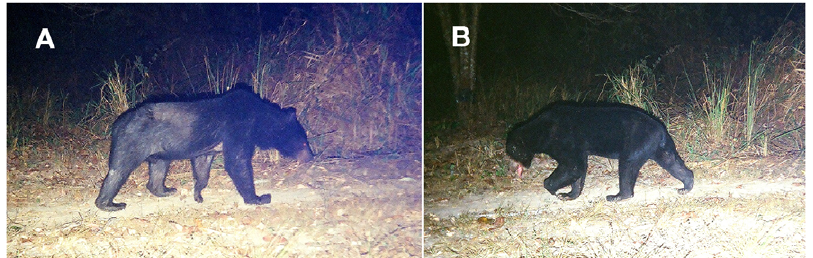
Figure 1. An Asiatic black bear (A) and sun bear (B) photographed at the same location in Thailand nine days apart (2009). These sympatric bear species co-occur at fine spatial scales, as seen here, throughout mainland Southeast Asia. Photographs: R. Steinmetz.